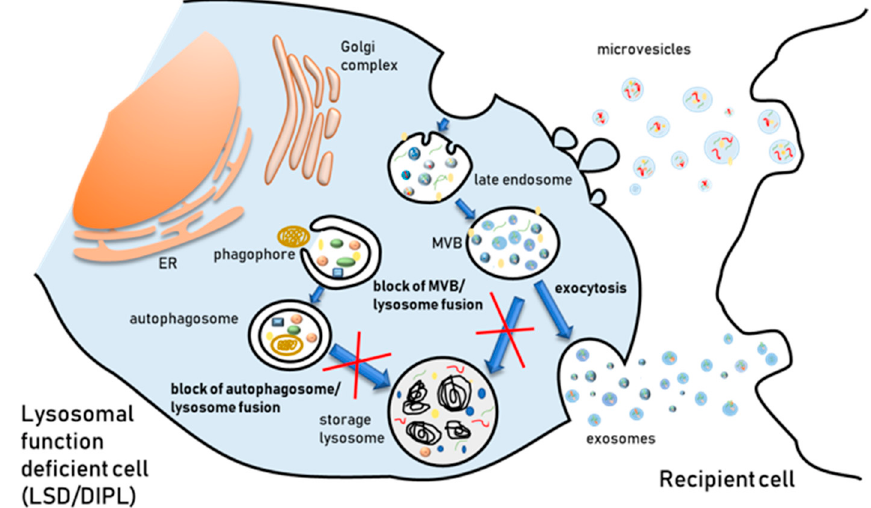
Figure 2. Representation of EV release induced by lysosomal storage in LSDs. Lysosomal storage results from the presence of undigested substrates caused by the accumulation of material either due to genetic deficiency of lysosomal enzymes or to treatment with drugs inducing the accumulation of phospholipids.